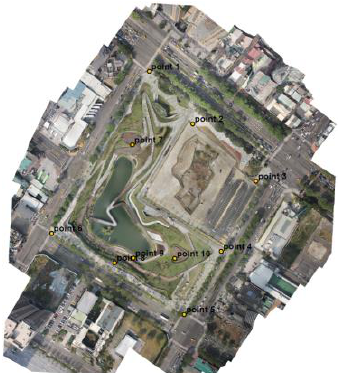
Figure 4 .(a) Ground control